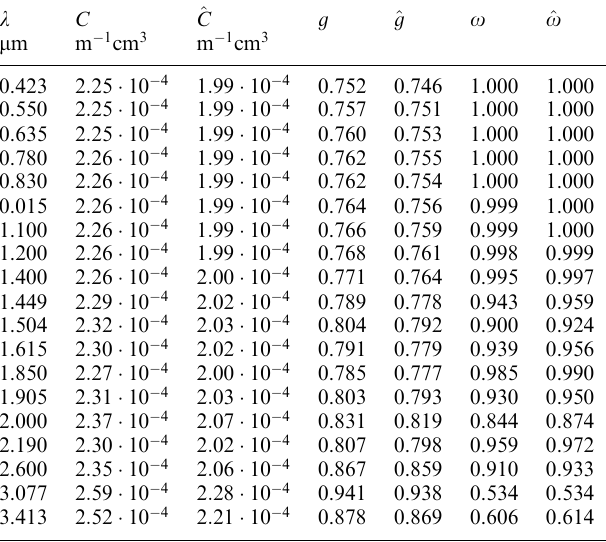
Table 7. Optical parameters of cirrus and contrail used in the solar region. Symbols without a hat denote cirrus parameters, symbols with a hat denote contrail